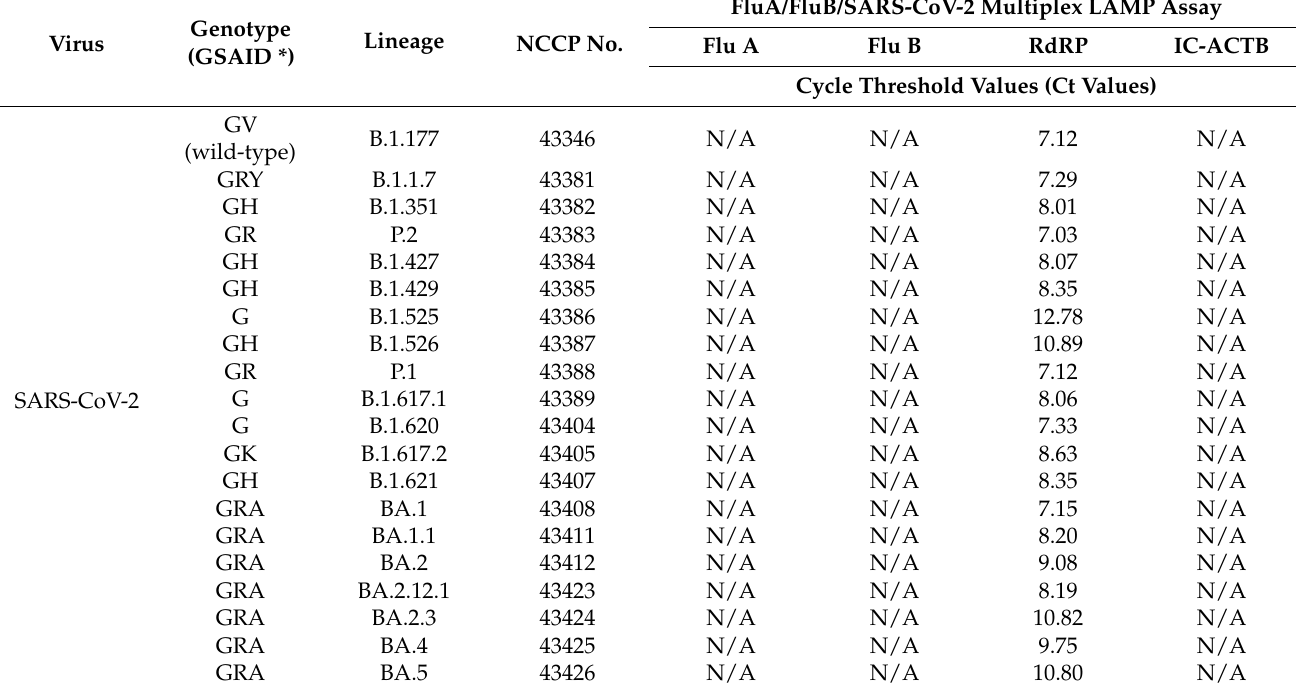
Table 8. The performance of FluA/FluB/SARS-CoV-2 multiplex LAMP assay for one SARS-CoV-2 wild-type sample and 19 SARS-CoV-2 mutant